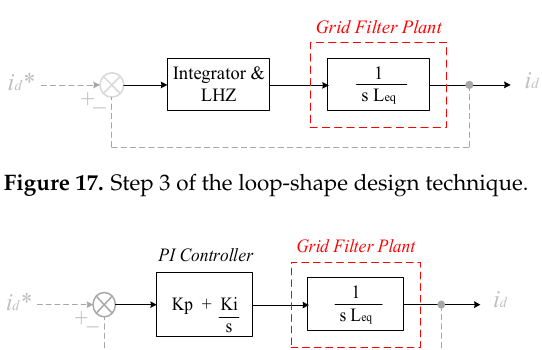
Figure 16. Step 2 of the loop-shape design technique.